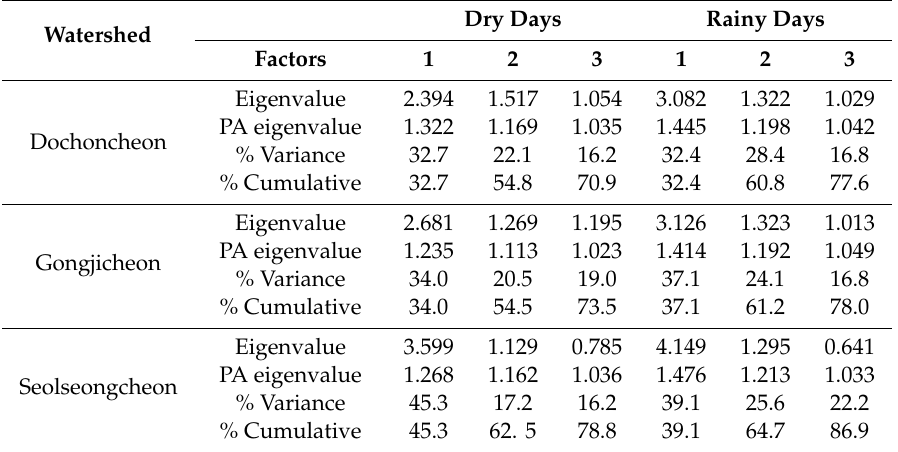
Table 5. Eigenvalues and proportion of variance explained by principal component analysis. Dry Days Rainy Watershed